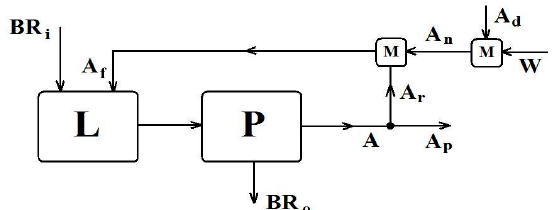
Figure 11. Conceptual design for a continuous BR leaching process.